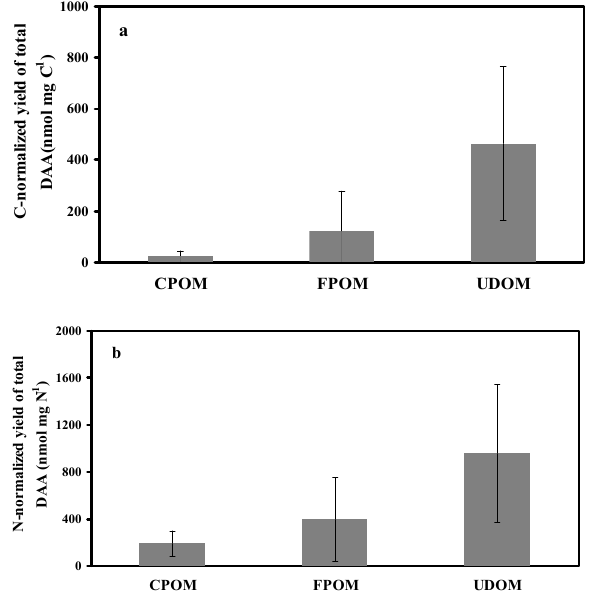
Fig. 6 Fig. 6. Spatial-averaged C- (a) and N- (b) normalized yields of total D-amino acids (total DAA, the sum of D-Ala, D-Glu, D-Asp and D-Ser) in the coarse particulate organic matter (CPOM), fine par- ticulate organic matter (FPOM), and ultra-filtered dissolved organic matter (UDOM) size fractions based on values at the 13 sampling stations. Bars represent standard deviations.